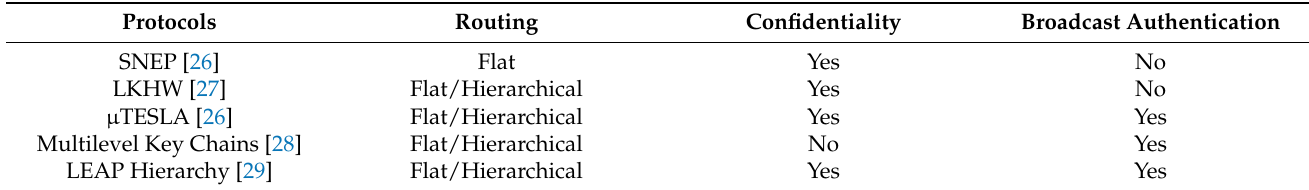
Table 1. Comparison of secure routing protocols for broadcast authentication.